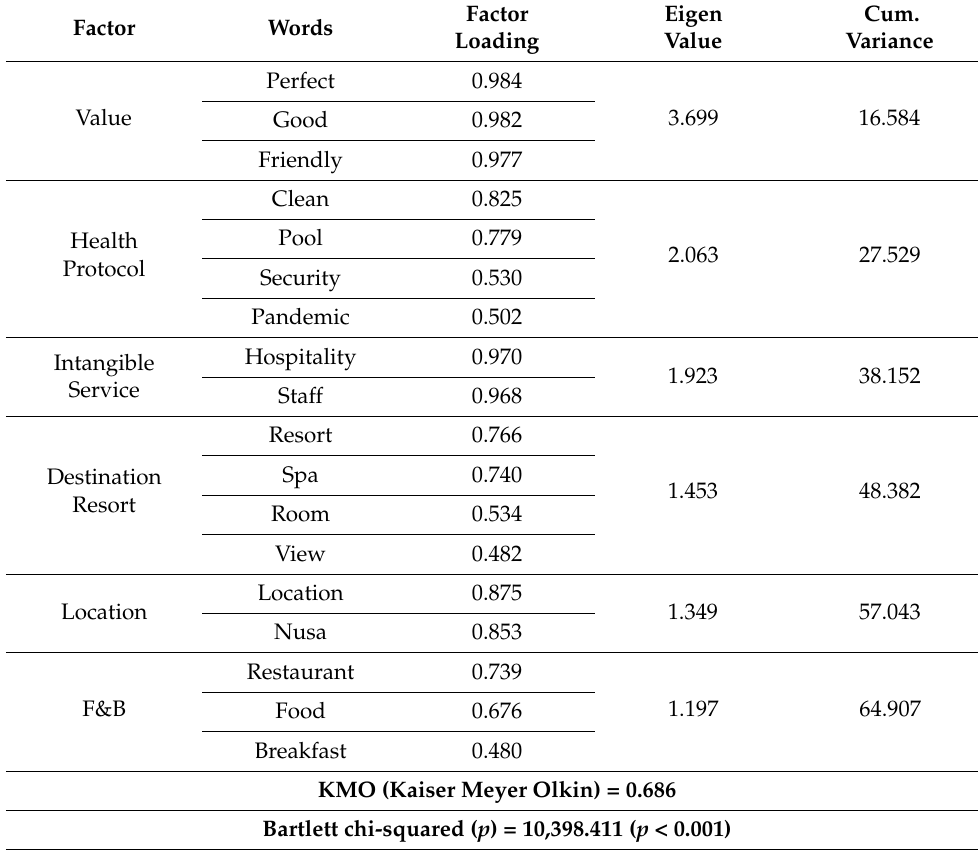
Table 6. Factor Analysis